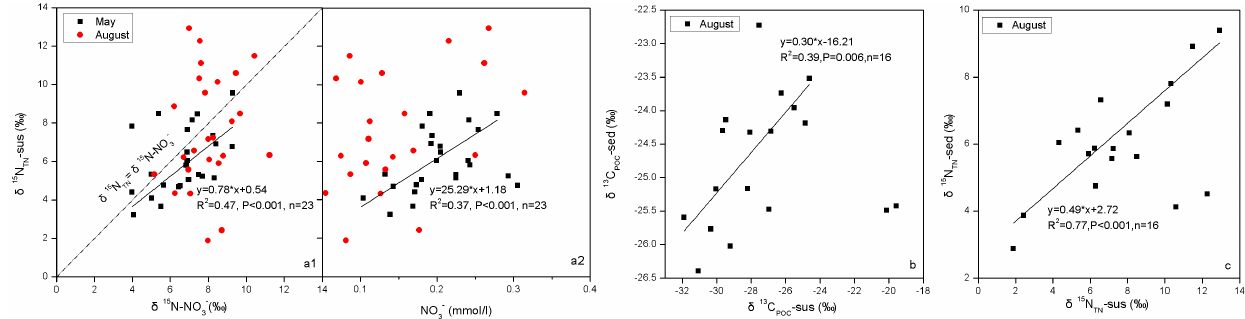
Figure 7. (a) Correlations of δ 15 N TN values in suspended matters and δ 15 N-NO − river water in the Wujiang River; (b) Correlations of δ 13 C values between suspended matters (sus) and surface sediments (sed); (c) Correla- tions of δ 15 N values between suspended matters and surface